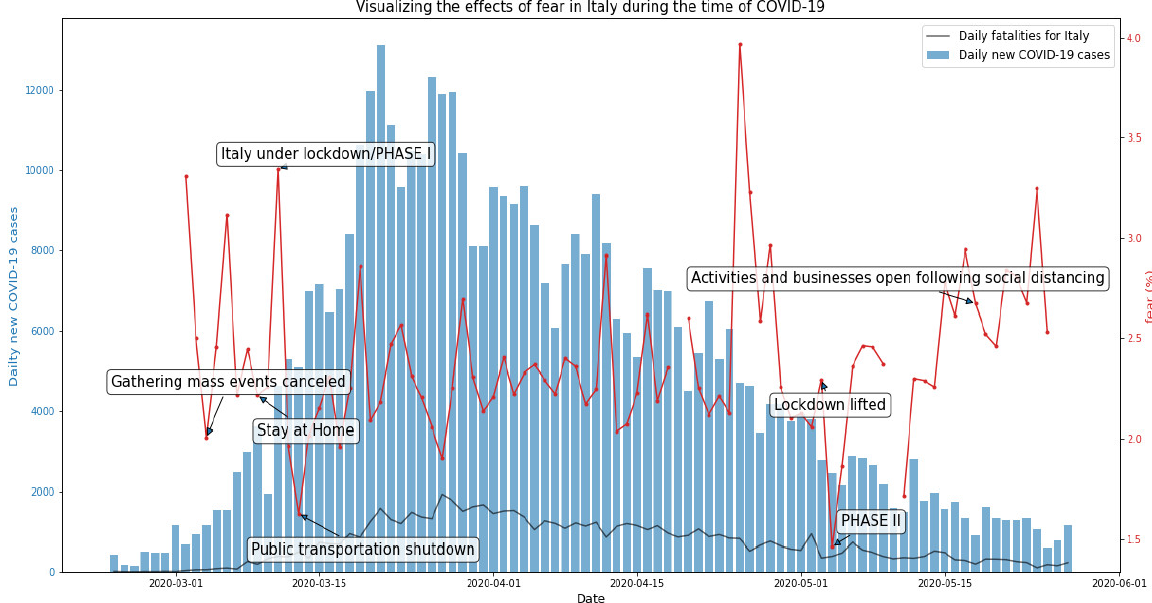
Figure 2. Fear-related tweets in Italy during the first wave of the COVID-19 pandemic.